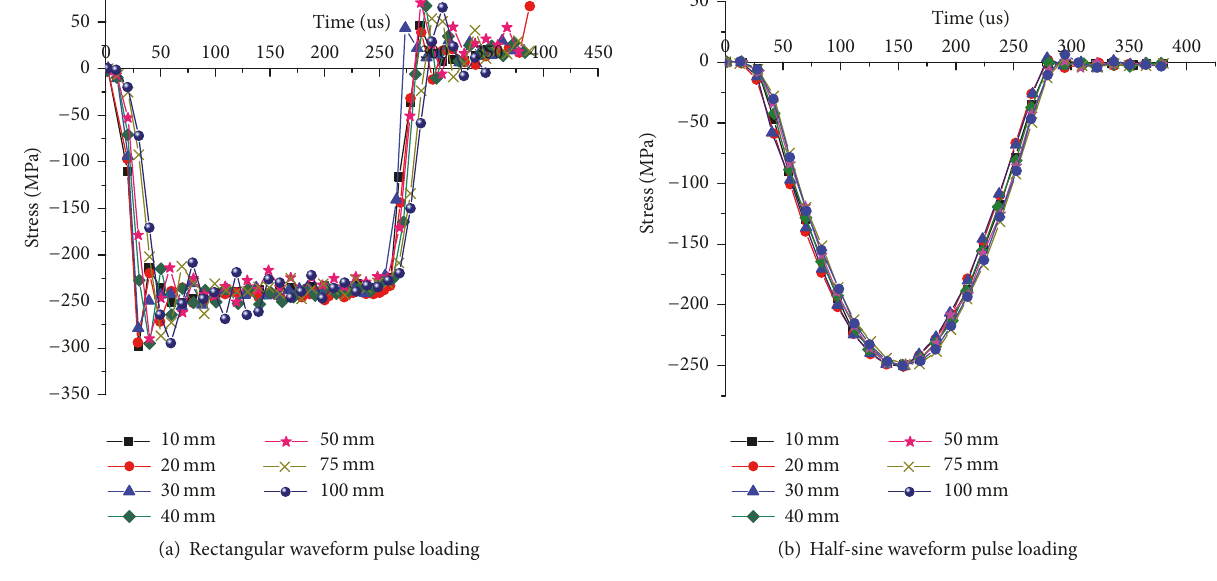
Figure 7: Time-history of stress pulses at different diameters ( 𝐿 = 100